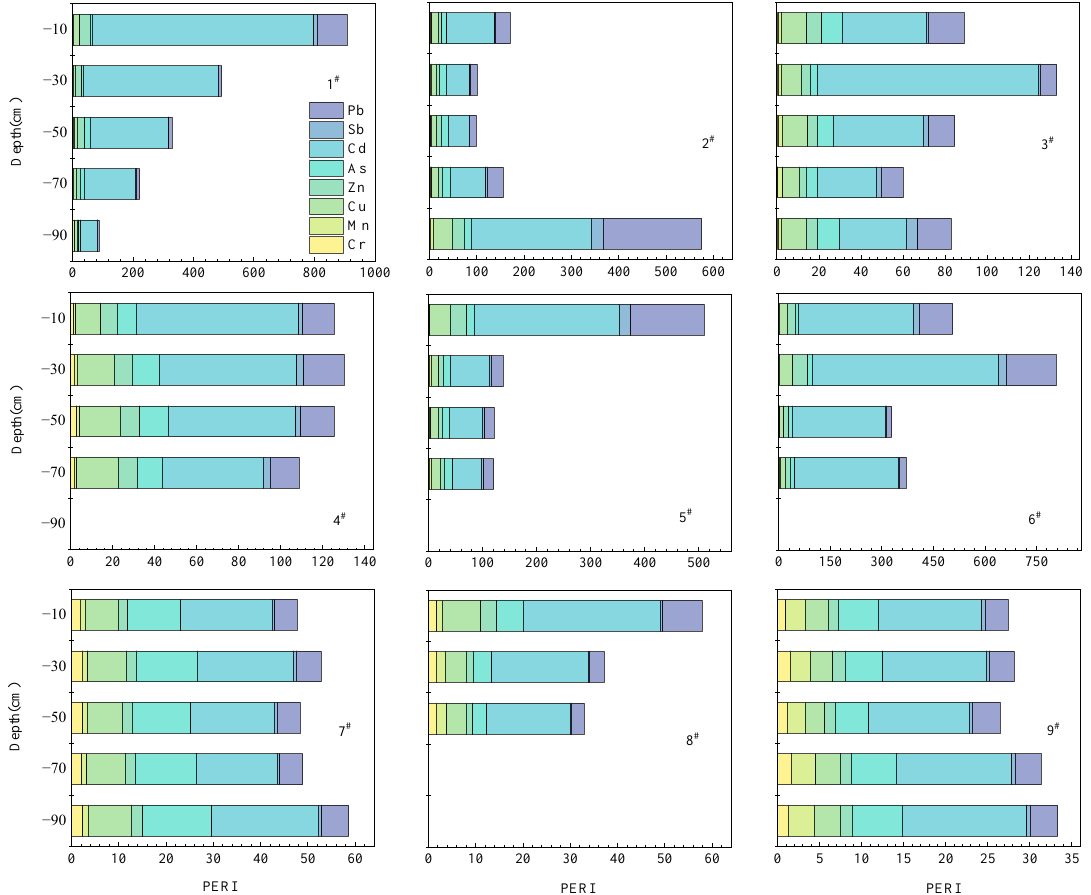
Figure 7. Soil heavy metal contamination level and ecological risk assessment based on PERI. Figure 8 depicts the findings of the ecological risk assessment of HM forms using RAC. At all sampling points, the RAC values of Cr were less than 1%, indicating a low ecological risk of Cr. The RAC values for Cu and Pb were primarily between 1% and 10%, which represented low risk levels. The Cr values of Mn showed medium risk levels (10% < RAC < 30%) in the topsoil (0 to − 60 cm) at sampling sites 1 # , 3 # , and 6 # , but